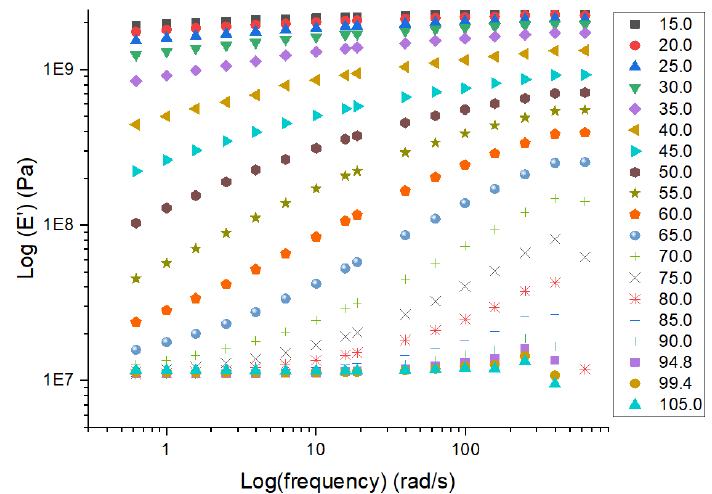
Figure 7. Storage modulus of Polymer B at various temperatures.